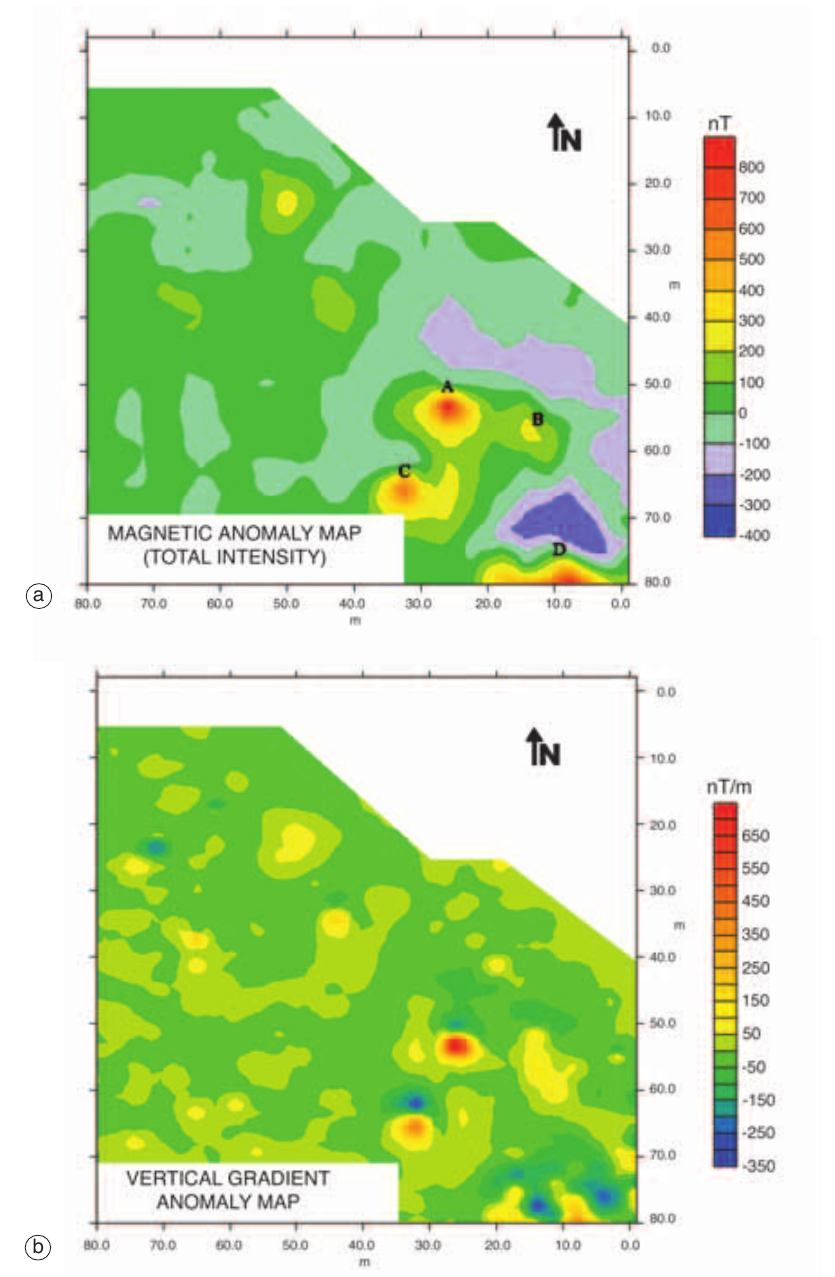
a Fig. 4a,b. New magnetic anomaly map of the total intensity field (a) and the magnetic vertical gradient map (b) after the removal of 160 steel drums on the restricted sector (about 5600 m 2 ).